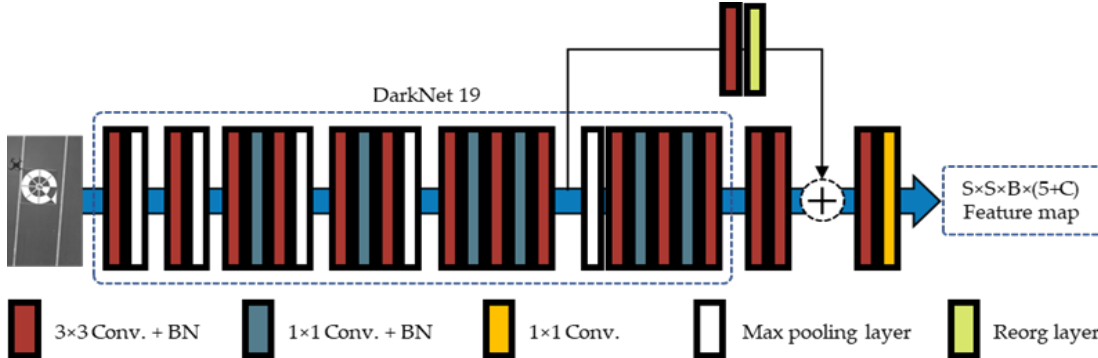
Figure 4. YOLOv2 backbone convolutional neural networks (CNN) architecture. The backbone network is a combination of the first 18 layers of Darknet19 and the YOLOv2 header. The header includes four convolutional layers and a Reorg layer. The Reorg layer refers to reorganization, which manipulates the output feature map of the 13th convolution of Darknet19 to obtain a reorganized feature map. The Concat layer concatenates the reorganized feature map and the output feature map of the 20th convolution. The final output is the feature map of shape S × S × B × (5 + C). In YOLOv2 [45], the Reorg layer was used to reshape the feature map, so that the width and height of the input feature map matched the other output feature map, and these two feature maps could be concatenated together. However, our marker datasets were quite different, compared to other object detection datasets like COCO [47], because the number of classes to be detected was only